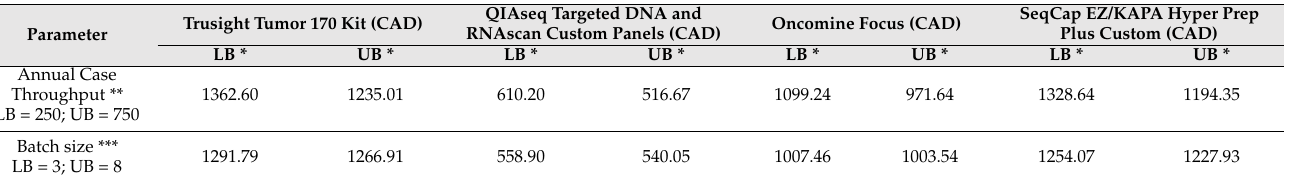
Table 4. One-way sensitivity analyses: per-sample costs by annual case throughput and batch size.